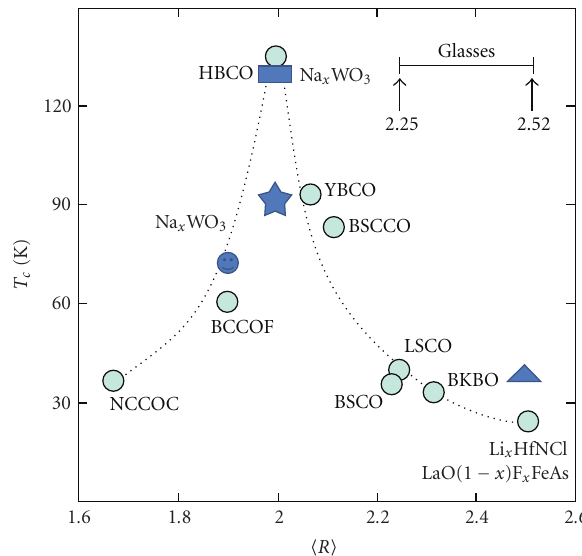
Figure 3: As in Figure 2, but now the noncuprate data have been added, so the Figure has become rather